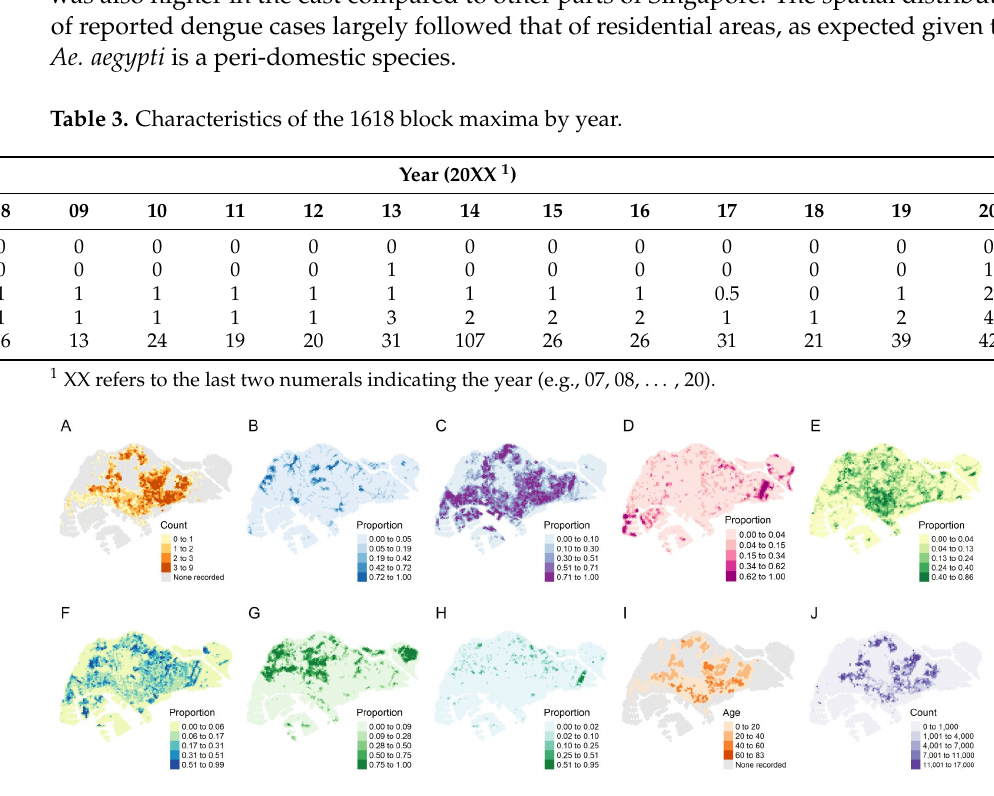
Table 3. Characteristics of the 1618 block maxima by year.